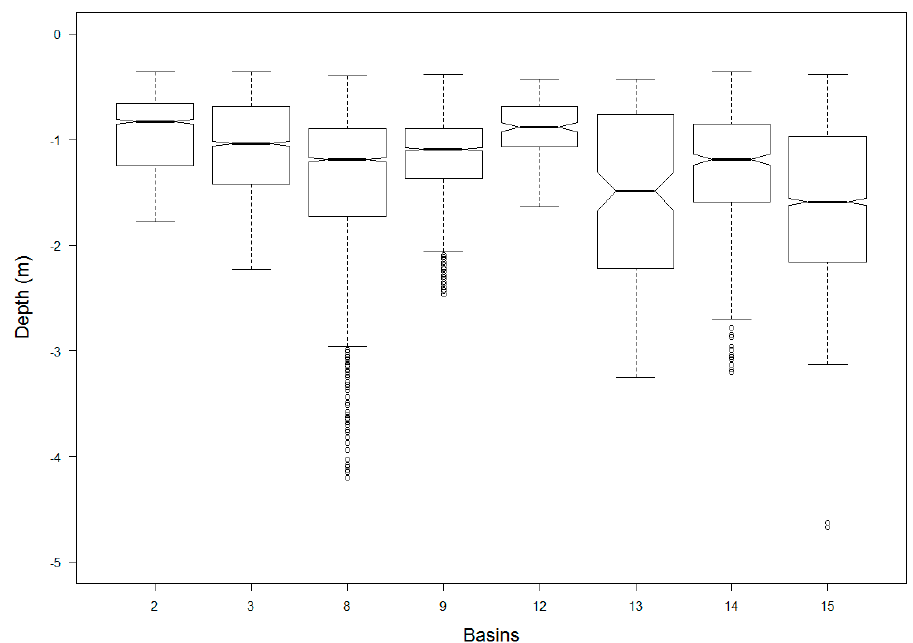
Figure 8. Sonar measurements in the Frio River survey. Basin #15 is deepest with a mean depth of 1.58 m and basin #12 is shallowest at 0.91 m.